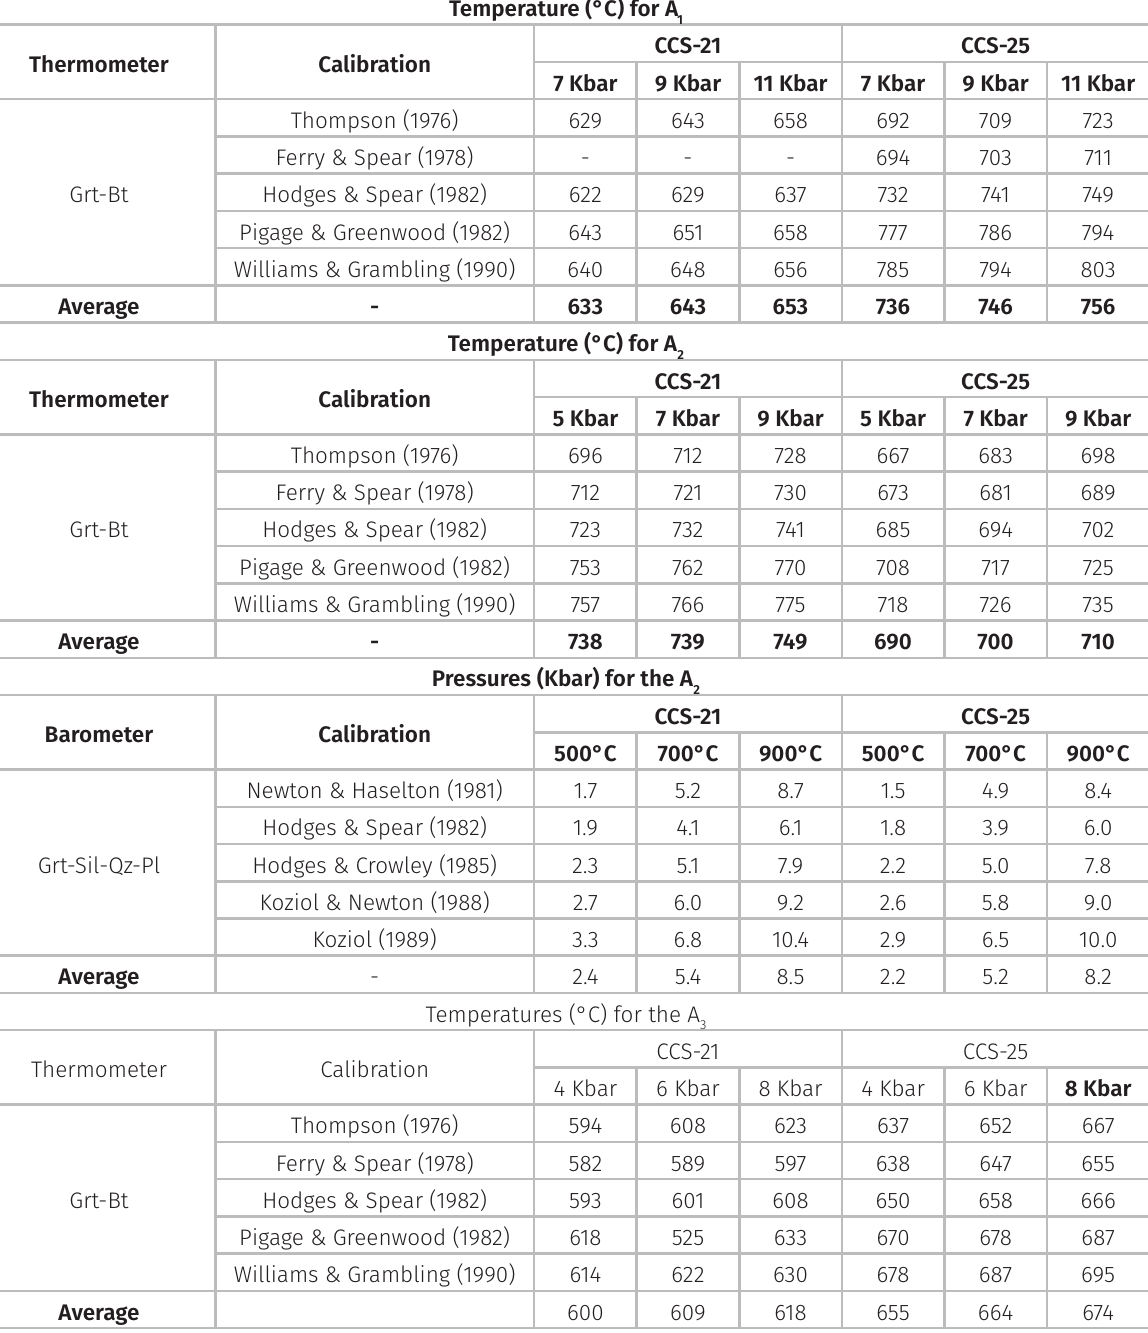
Temperature (°C) for A 1